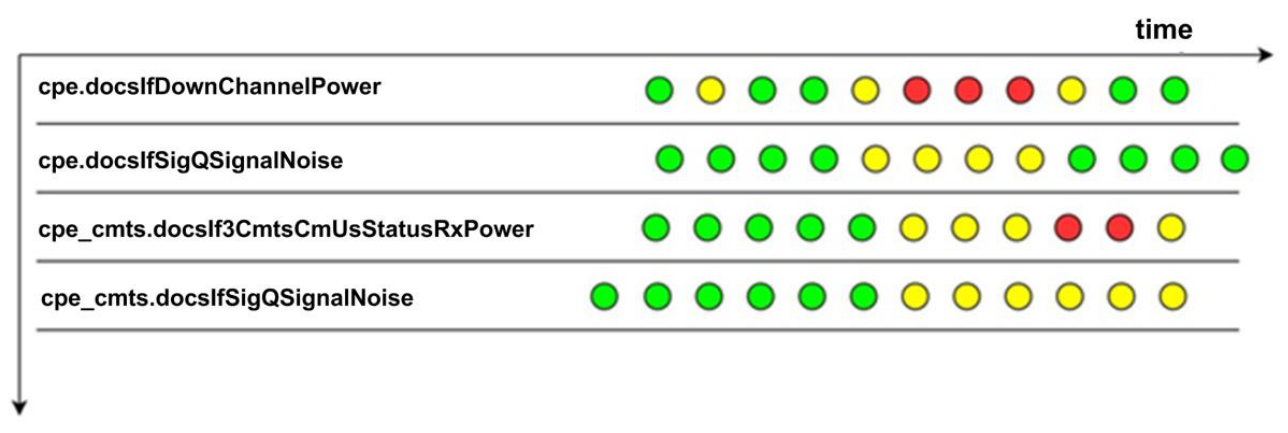
Figure 7. Merged performance grades for CPE (red circle—grade 1, yellow circle—grade 2, green circle—grade 3).